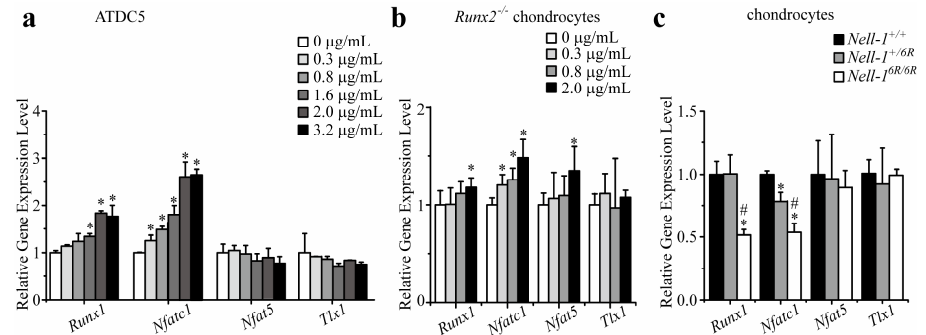
Figure 1. Nell-1 selectively alters the expression levels of Runx3 -promoter binding candidates in chondrocytes. ( a ) Expression levels of Runx3 -promoter binding candidates in monolayer cultured ATDC5 cells after stimulation with exogenous Nell-1 for 3 h. *: p < 0.05 vs. 0 µ g/mL Nell-1; ( b ) Expression levels of Runx3 -promoter binding candidates in monolayer cultured Runx2 − / − rib chondrocytes after stimulation with exogenous Nell-1 for 12 h. *: p <0.05 vs. 0 µ g/mL Nell-1; ( c ) Expression levels of Runx3 -promoter binding candidates in rib chondrocytes with different genotypes of Nell-1. *: p < 0.05 vs. Nell-1 +/+ chondrocytes; # : p < 0.05 vs. Nell-1 +/6R chondrocytes. Mean + SD of three ( a , b ) or six ( c ) independent experiments performed in triplicate are